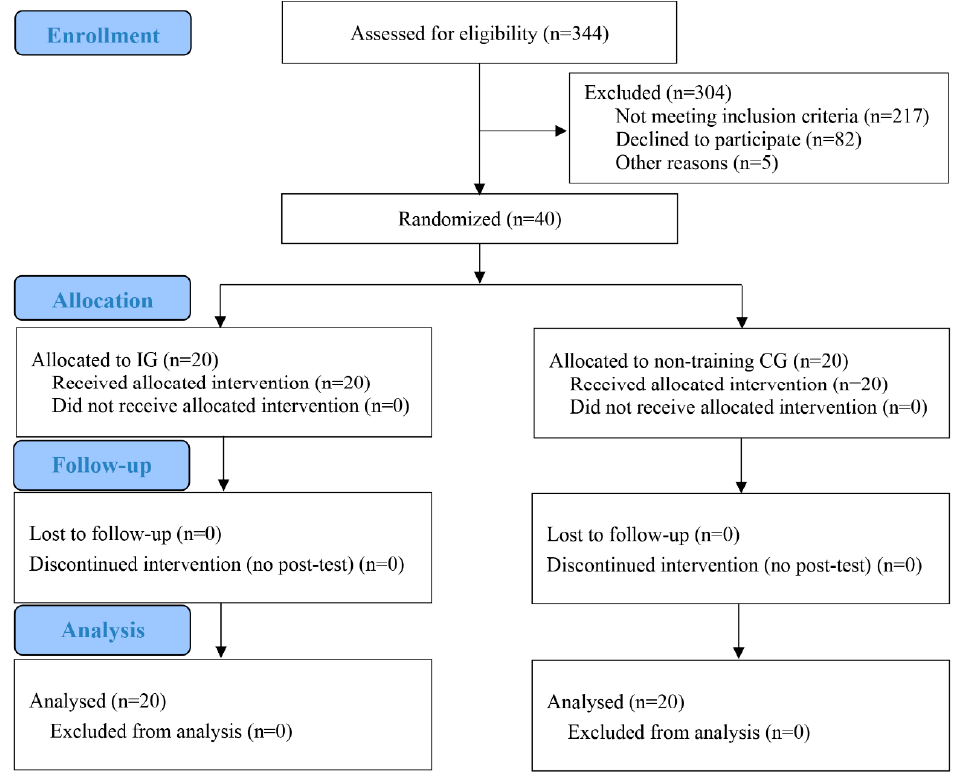
Figure 2. Consolidated standards of trials flow